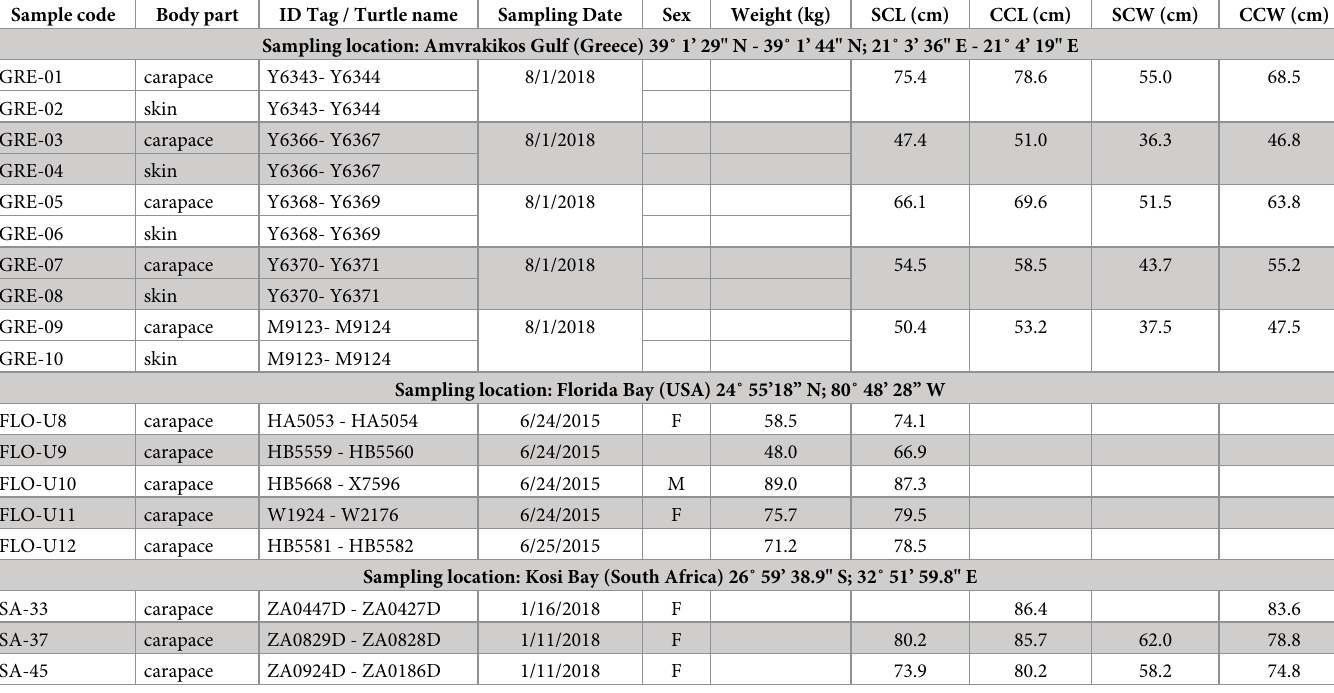
Table 1. List of samples and information on loggerhead sea